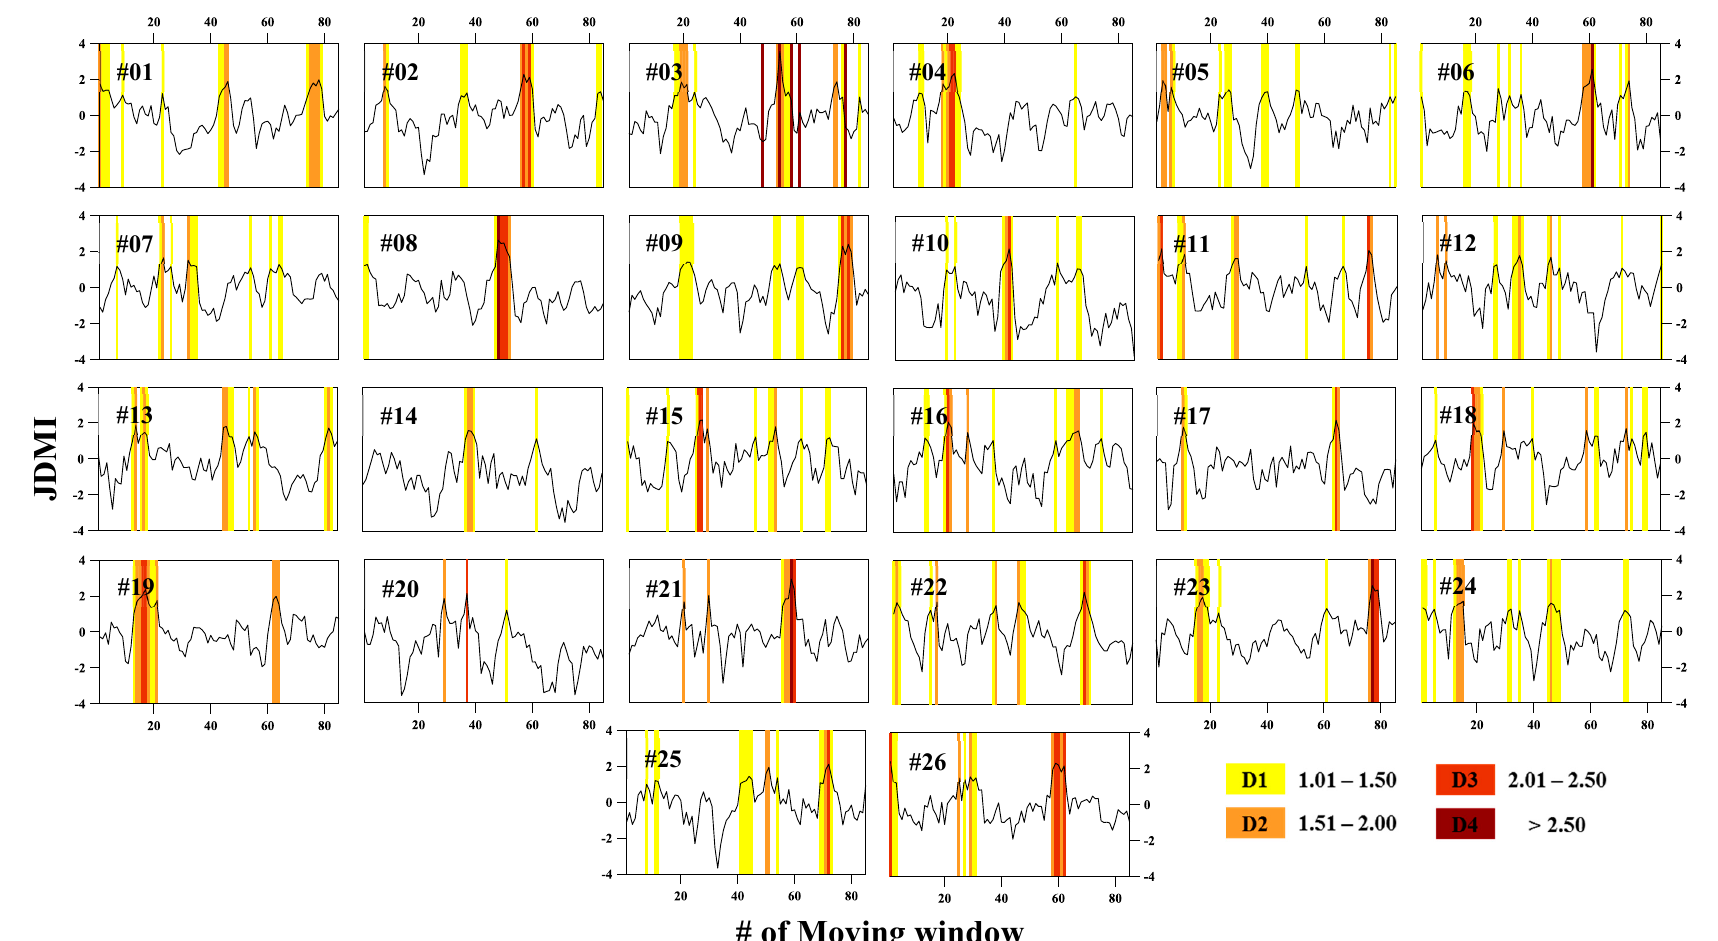
Figure 4. Joint drought management index (JDMI) estimation and drought state classification of 26 scenarios.